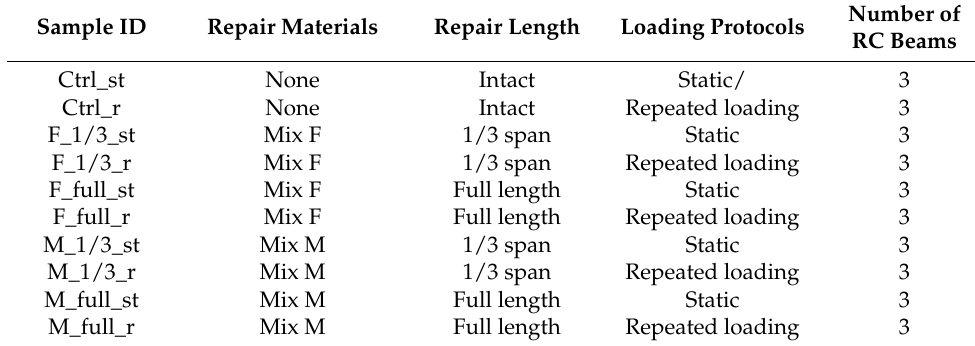
Table 3. Description of test